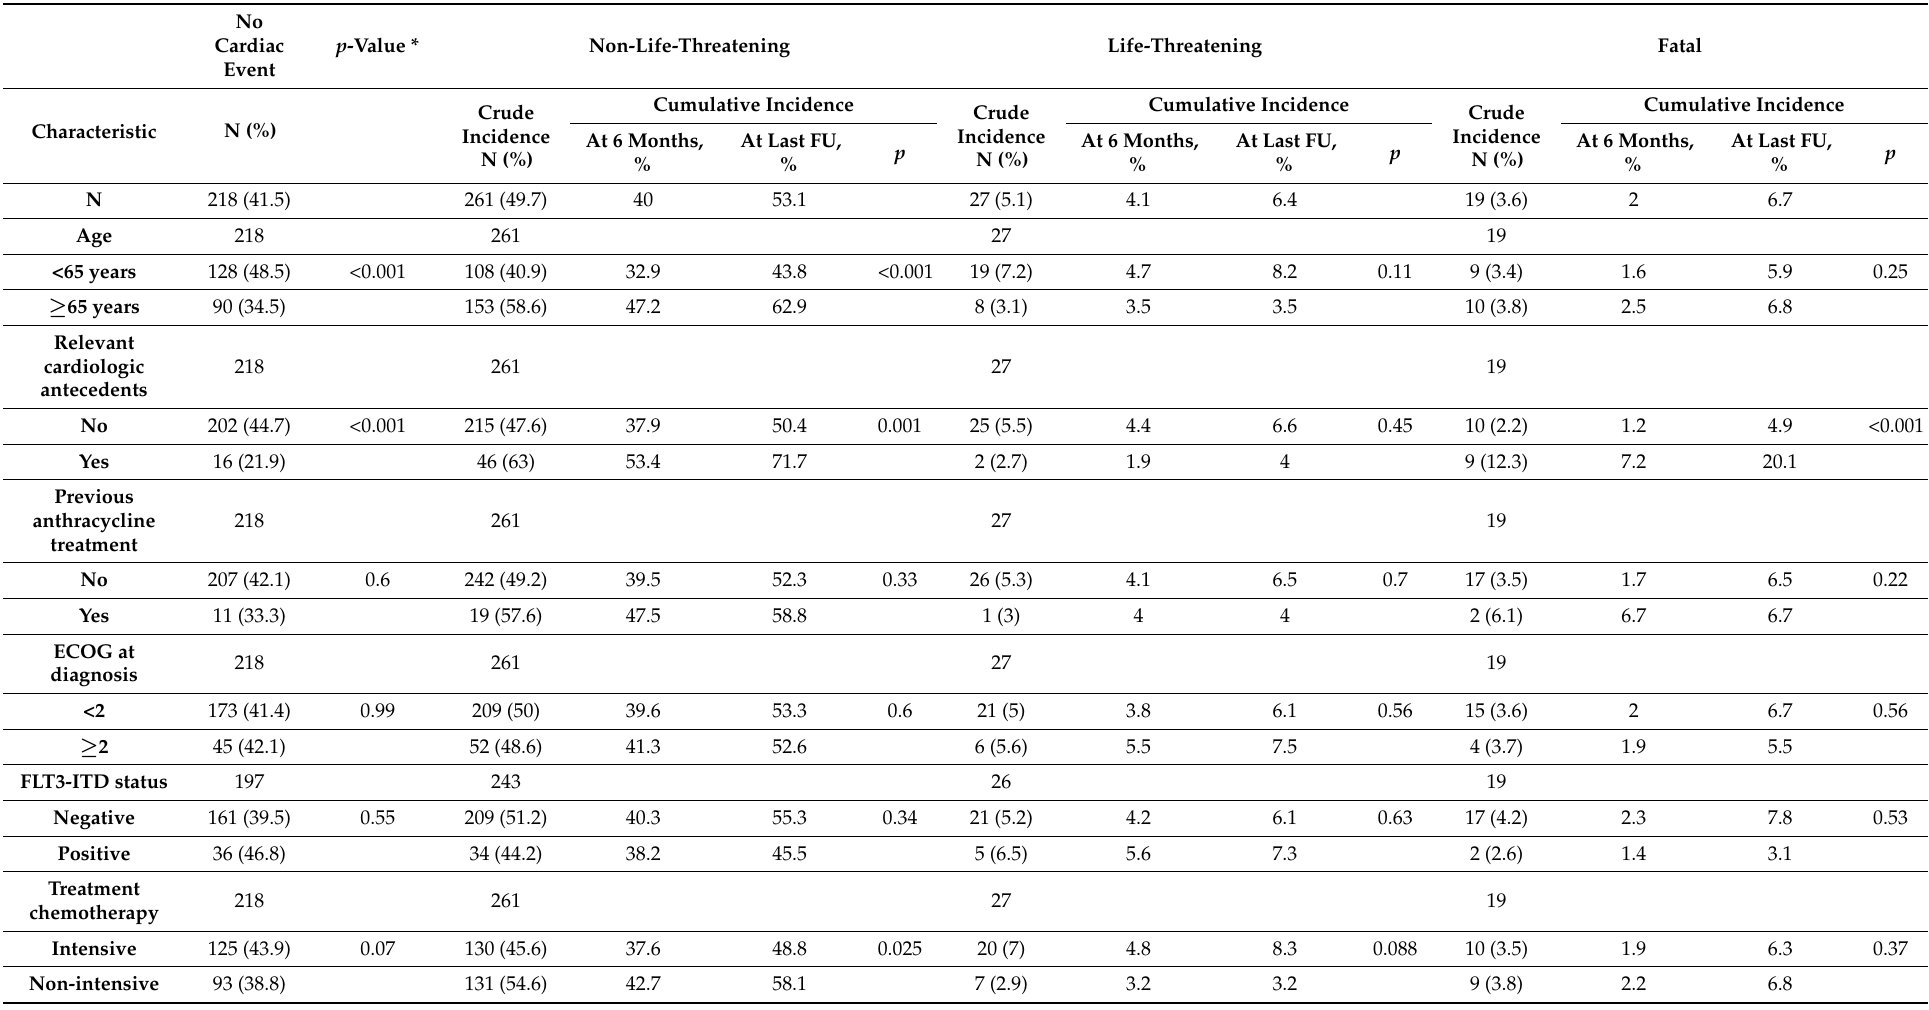
Table 4. Overall cohort: Crude and cumulative incidence of cardiac events (fatal vs. life-threatening vs. no cardiac event) according to demographic, clinical, and biological characteristics of patients at